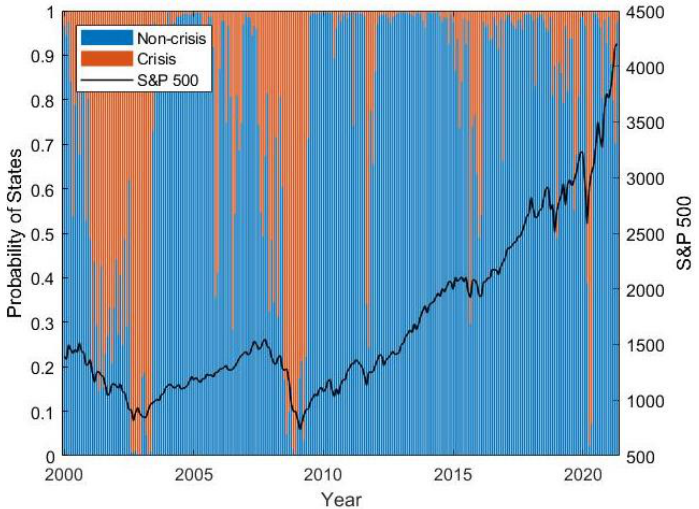
Figure 3. One-month-ahead predictions for Model 1.